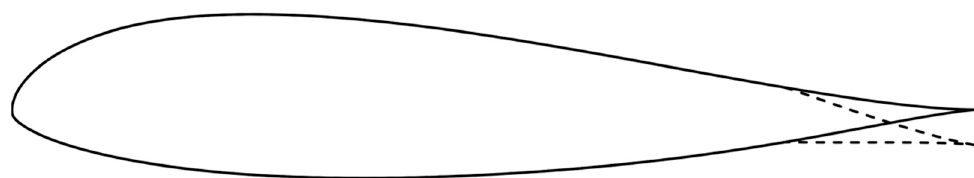
Figure 4. Parametric studies for the determination of the required number of sections.